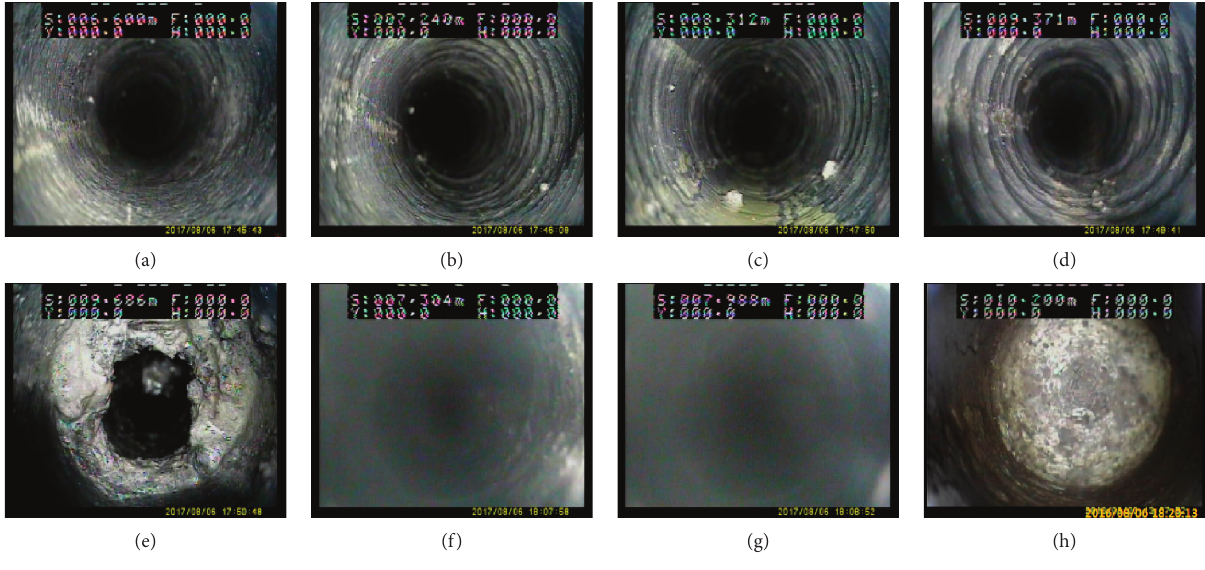
Figure 12: The distribution of the surrounding rock (3.8–10m) outside the anchor zone. (a) 4.1m. (b) 4.7 m. (c) 5.9m. (d) 6.9 m. (e) 7.2m.